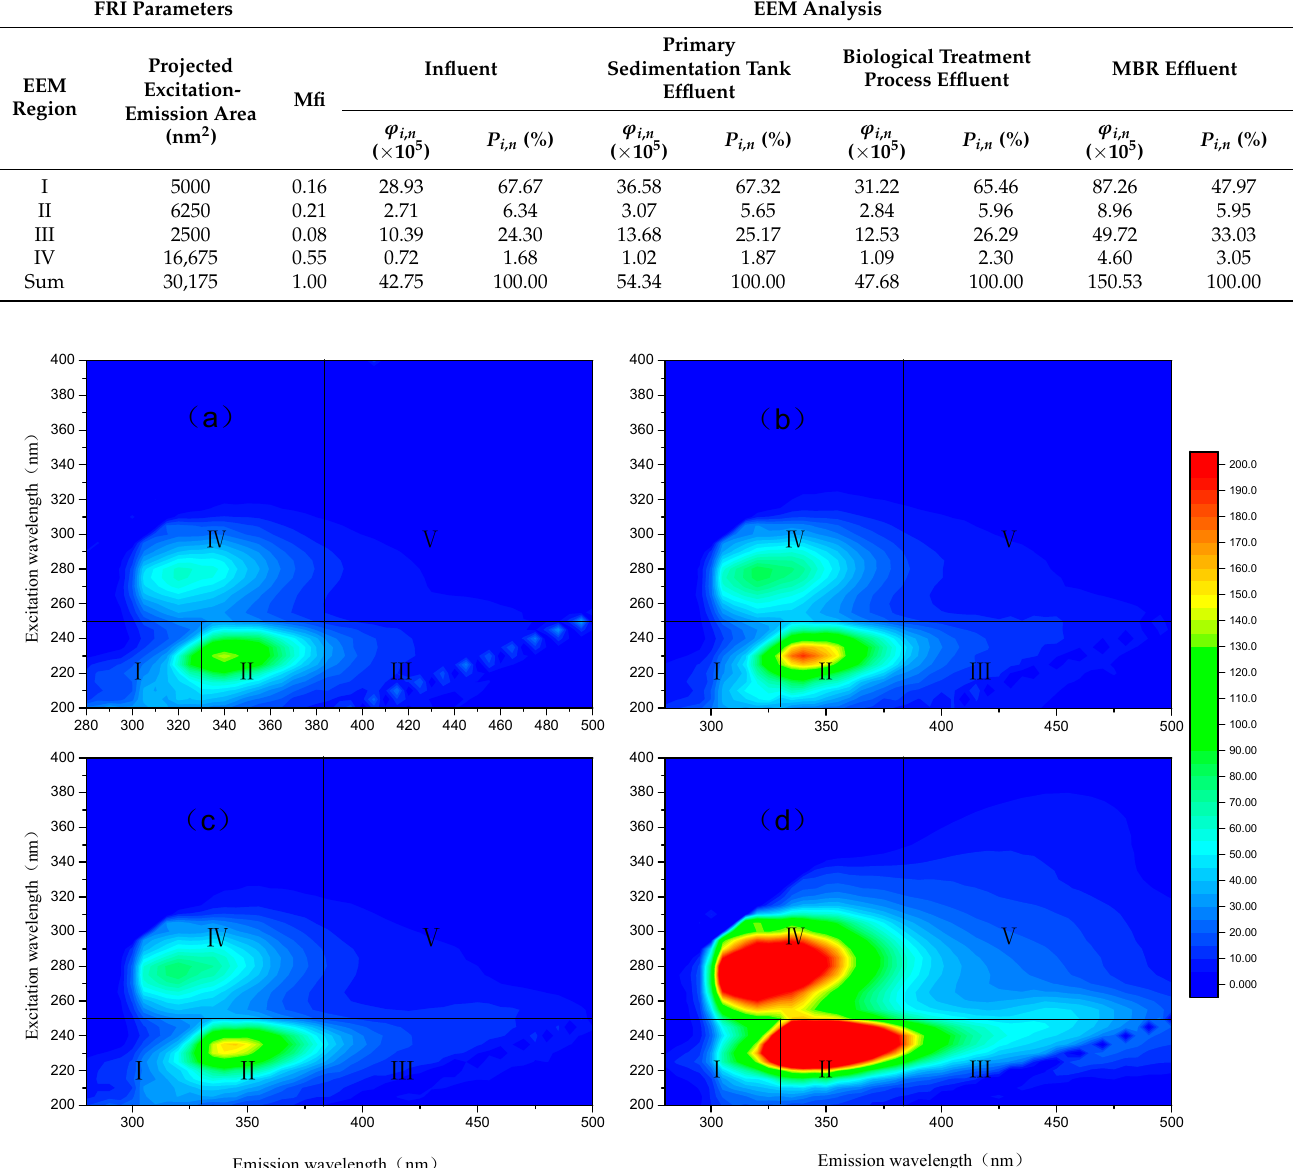
Figure 2. Three-dimensional EEM of DOM in AAO-MBR treatment process: ( a ) Influent, ( b ) AGC effluent, ( c ) AAO effluent, and ( d ) MBR effluent.